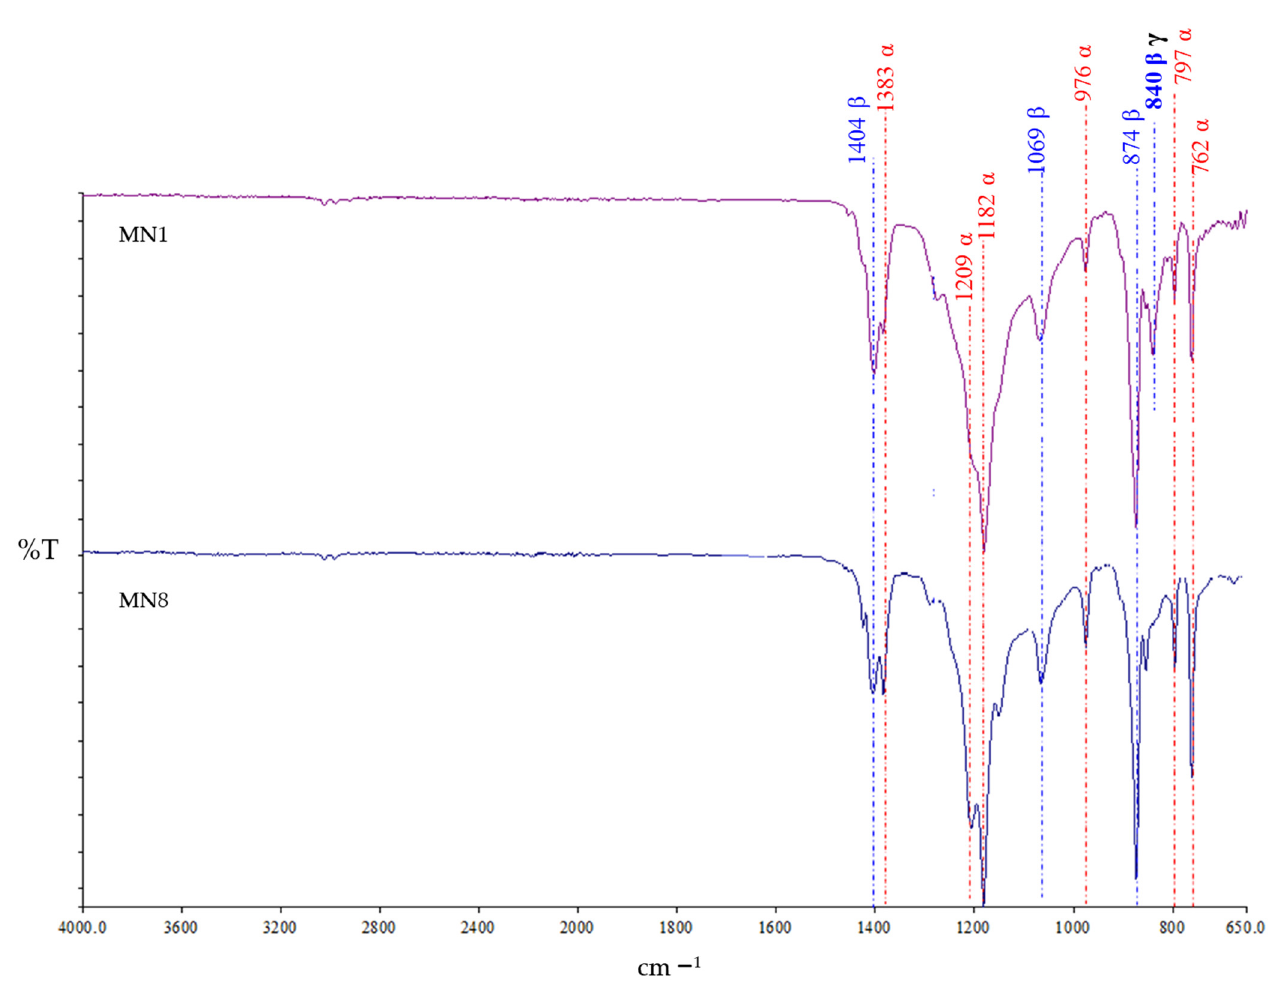
Figure 9. ATR-FTIR spectra highlighting α and β phases of the MN1 and MN8 membranes prepared without additives and with additives (PVP K17 and PEG 200), respectively.